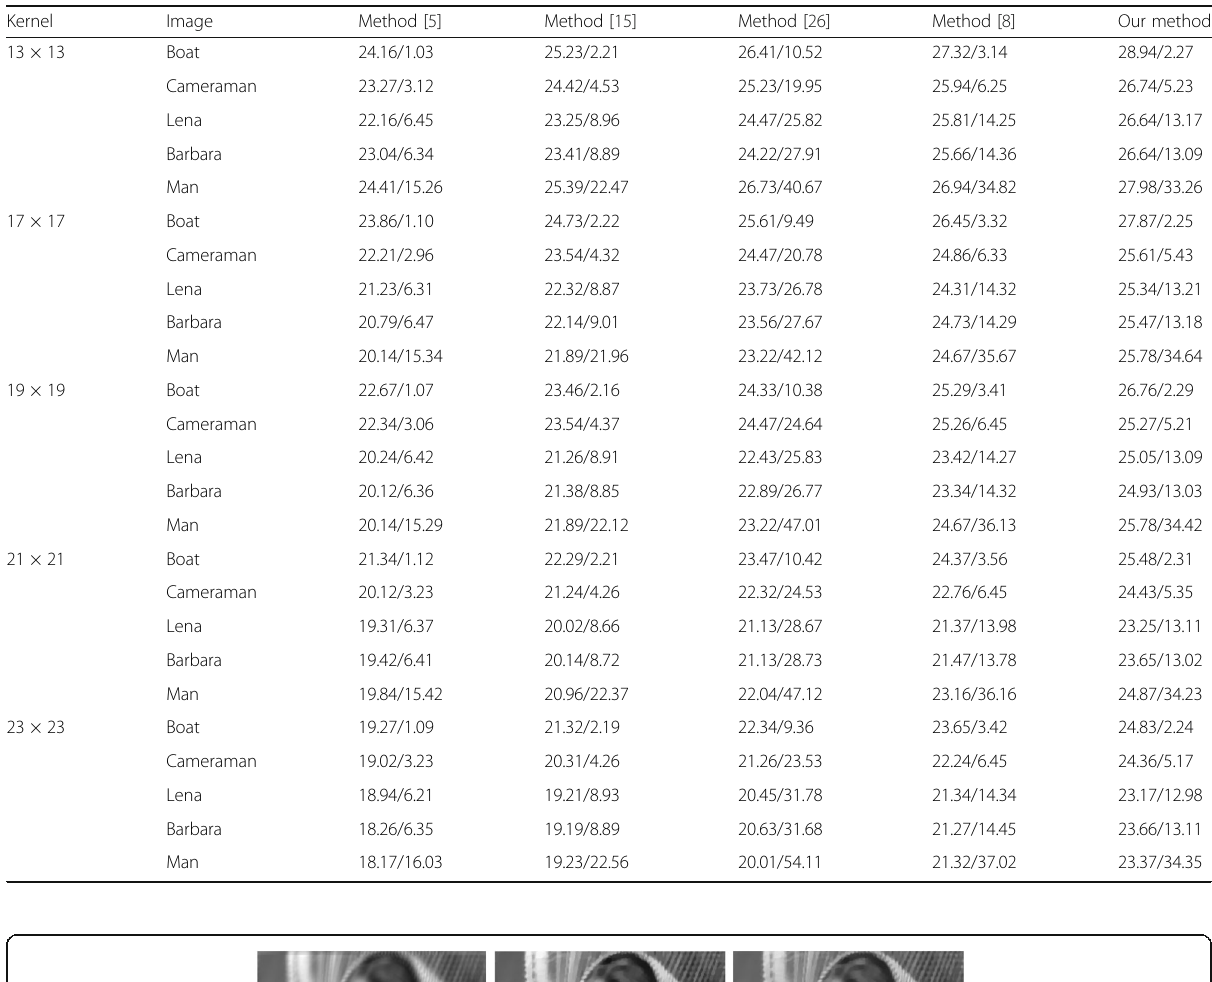
Table 1 PSNR (dB) and CPU times for the deblurring experiments in Fig. 4 (PSNR/times) Kernel